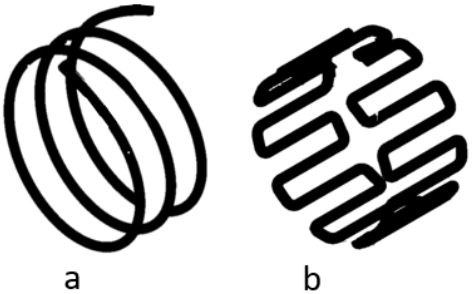
Figure 7. ( a ) Helical water jacket. ( b ) Axial water jacket.